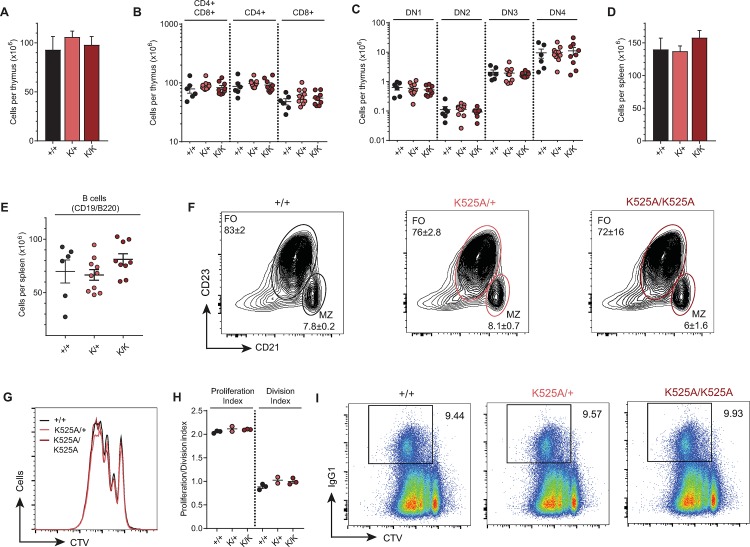
ATP-dependent helicase function of Recql4 is not required for B or T cell development.(A) Leukocyte counts in thymus. (B) Absolute numbers of double positive CD4/CD8, CD4+, and CD8+ T lymphocytes in thymus. (C) T cell progenitor populations (DN1-DN4). (D) Leukocyte counts in spleen. (E) B lymphocytes in spleen. (F) Representative (n = 2 mice per genotype) FACS plots of B220+CD19+ gated splenocytes stained for follicular (FO, CD23hiCD21low) and marginal zone (MZ, CD21hiCD23low) B cells. Numbers indicate cells x 106 per spleen. (G) CellTrace Violet (CTV) dilution in purified B cells treated for 96 hours with 15μg/ml LPS + 10ng/ml IL4. Representative examples of n = 3 mice per genotype. (H) Quantification of cell division (average division per cell in culture) and proliferation (average division/per dividing cell in culture) indices. n = 3 mice per genotype. (I) In vitro class-switch recombination to IgG1 in purified B cells treated as in panel B. Representative examples of n = 2 mice per genotype. Data expressed as mean ± SEM, Student’s t test (A-E). Experiments were independently executed on separate cohorts, with results pooled for presentation. K = K525A.